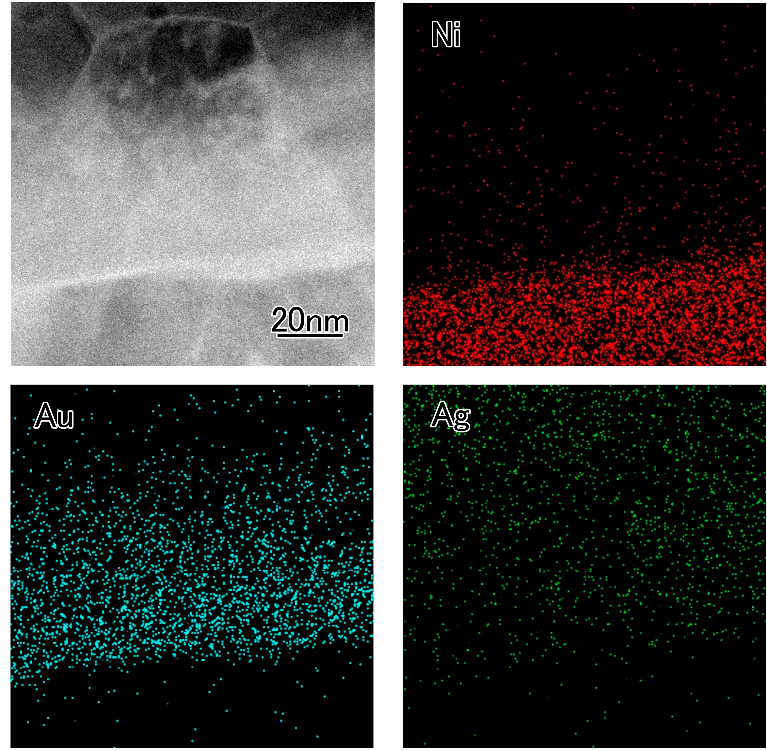
Figure 11. EDS mapping of the Ag grain around the interface.